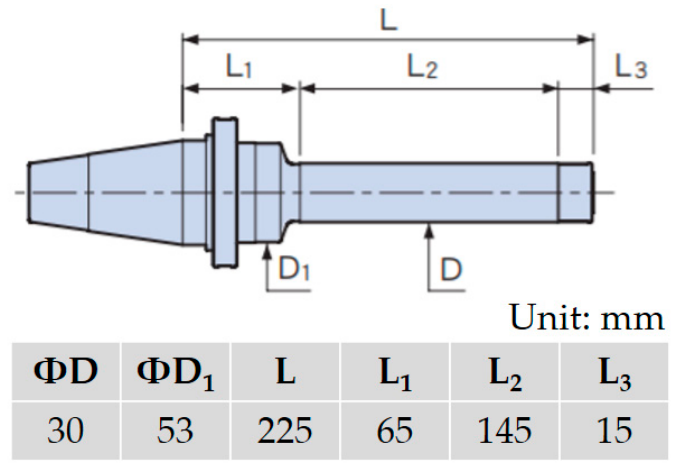
Figure 3. The specifications of the MISUMI NT50-CMA30-225 (Ikoma, Japan) test bar [36].